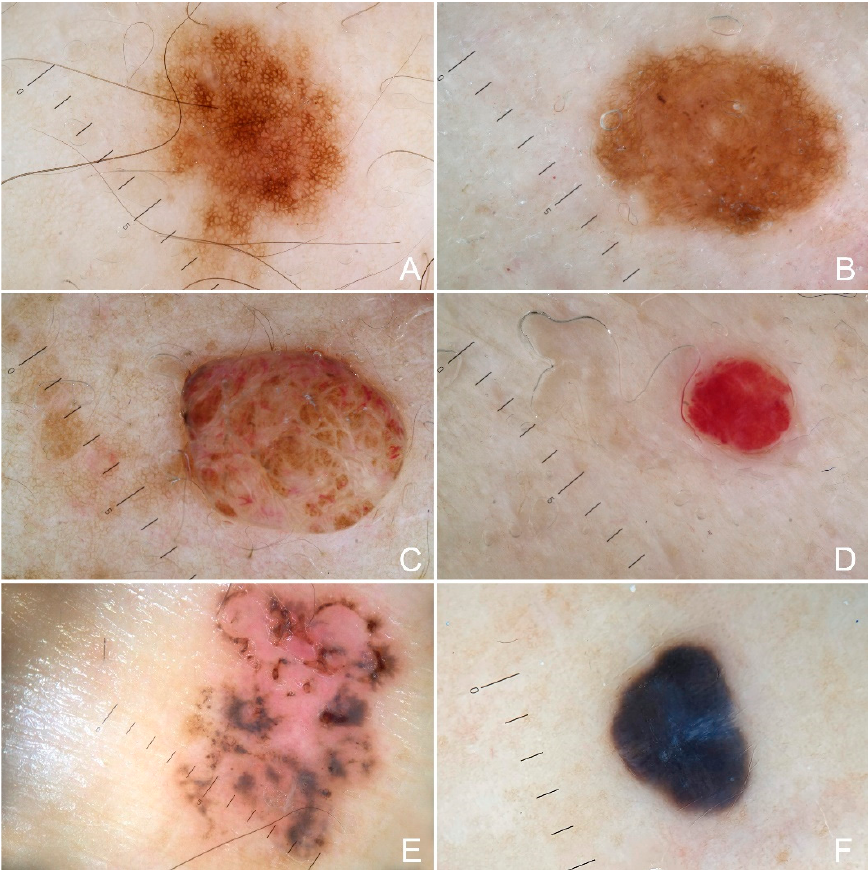
Figure 1. Cutaneous lesions observed in patients with Lynch syndrome (LS) ( A ) . A pigmented lesion with a typical uniform reticular pattern; ( B ) a pigmented lesion with a mixed pattern composed of a central structureless area surrounded by a network; ( C ) a dermal nevus showing a uniform and unspecified dermal pattern; ( D ) a cherry angioma with uniform reddish pattern; ( E ), pigmented basal cell carcinoma and ( F ) uniform dermal pattern in a blue nevus.